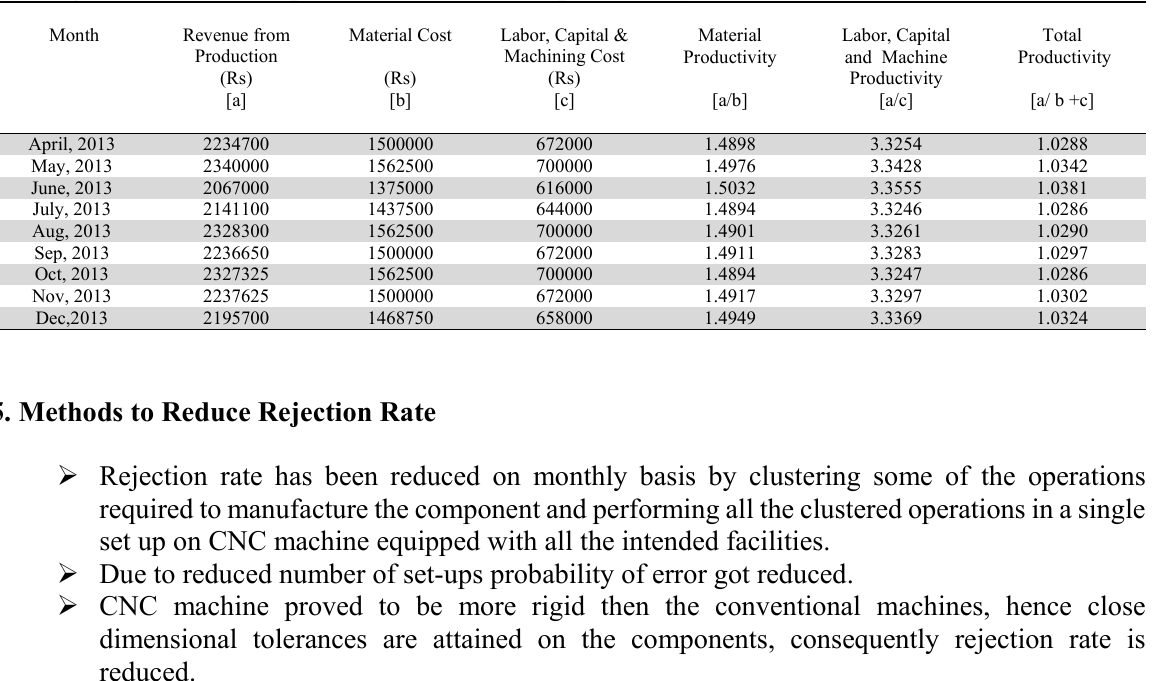
Existing material, labor-capital-machine and total